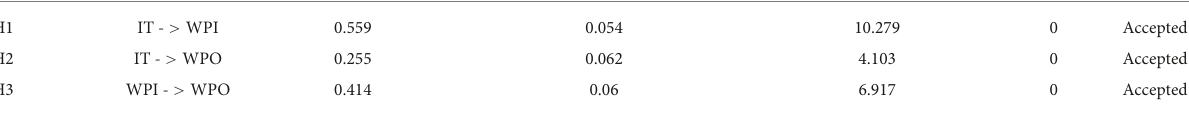
TABLE 5 Indirect